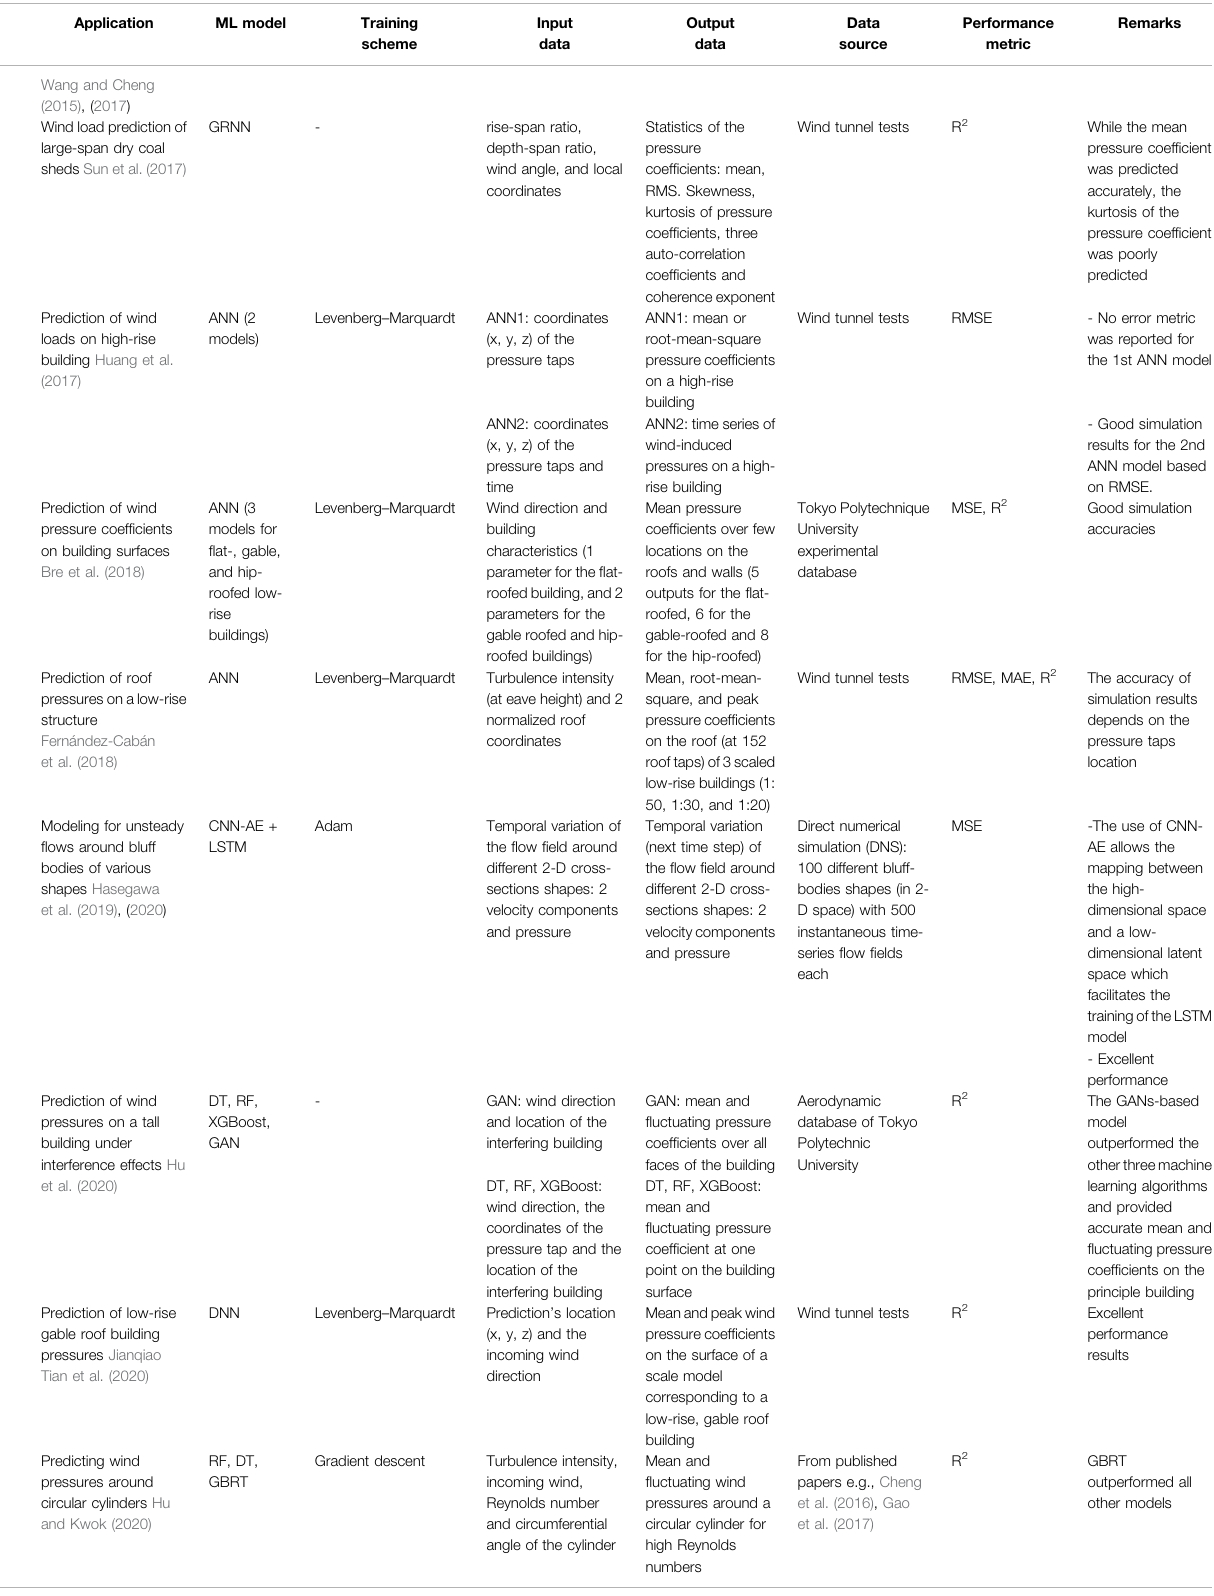
TABLE 5 | ( Continued ) Summary of ML applications for aerodynamics and